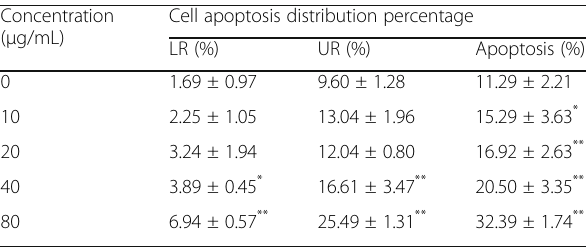
Table 2 The influence of lignans from the pine needles of CD on A549 cell apoptosis ( x ± s , n = 3)